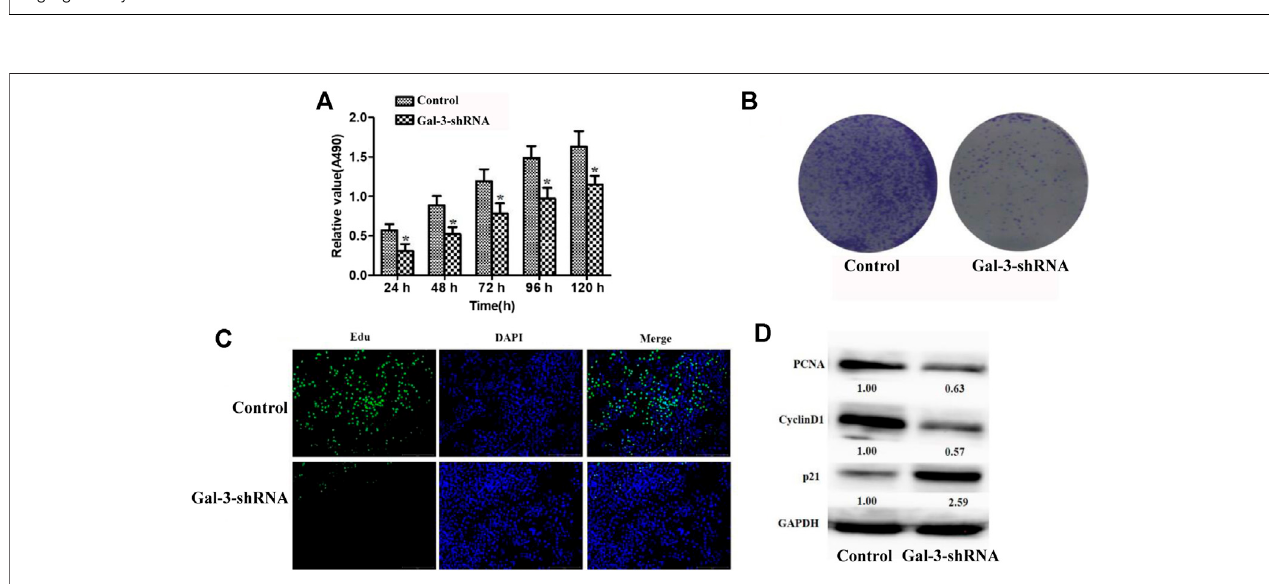
FIGURE2| KnockdownofGal-3inhibitstheproliferationabilityofICCcells (A) MTTassaywasutilizedtoassesstheproliferationactivityofICCcells (B) Decreased number of colonies formed was observed after Gal-3 expression was depleted (C) The number of Edu-positive cells was decreased after Gal-3 knockdown (D) The protein expression level of PCNA, Cyclin D1, and p21 was